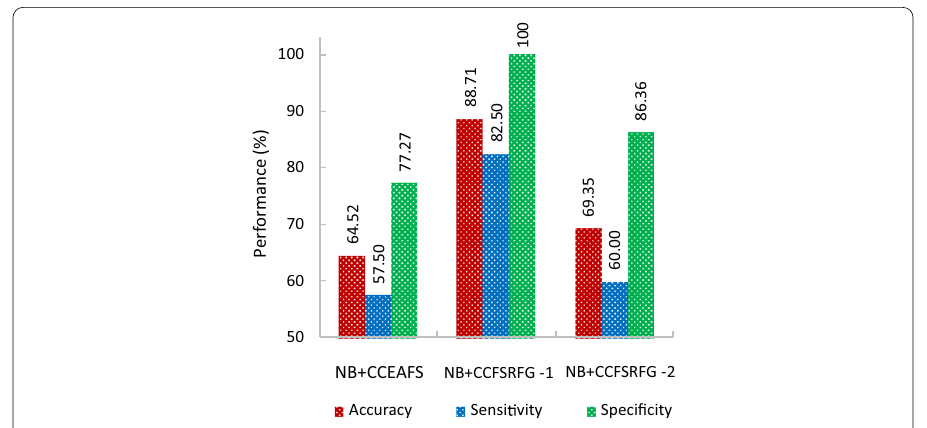
Fig. 12 Performance evaluation of the NB classifier on the Colon Cancer